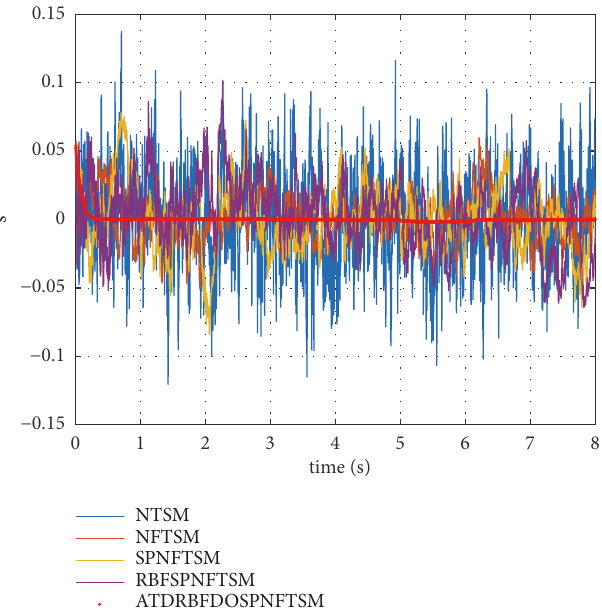
Figure 13: Sliding mode 𝑠 response curve (adding noise).